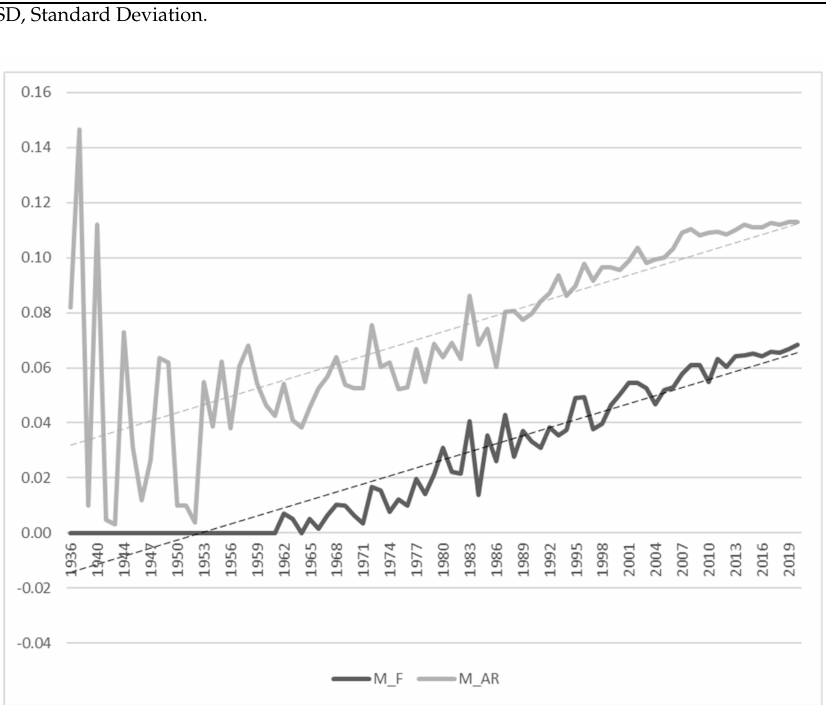
Figure 4. Trends in level of mean inbreeding (M_F) and mean average relatedness (M_AR) by year of birth. Linear trend lines are represented using dotted lines whose color is consistent with the corresponding solid